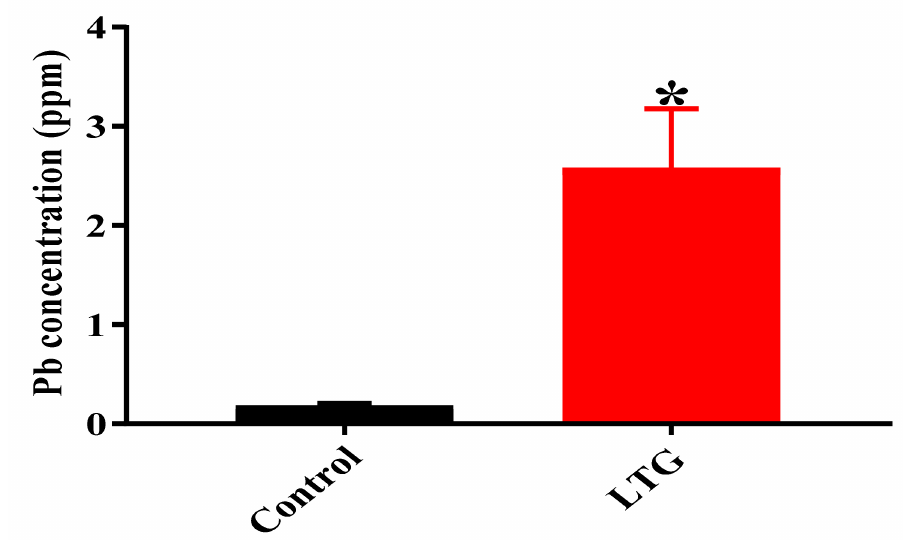
Figure 6. Concentration (ppm) of Pb in rats’ cerebellums after induction of Pb toxicity for four weeks. Data are represented as mean ± SEM ( n = 3); * p < 0.05 vs.